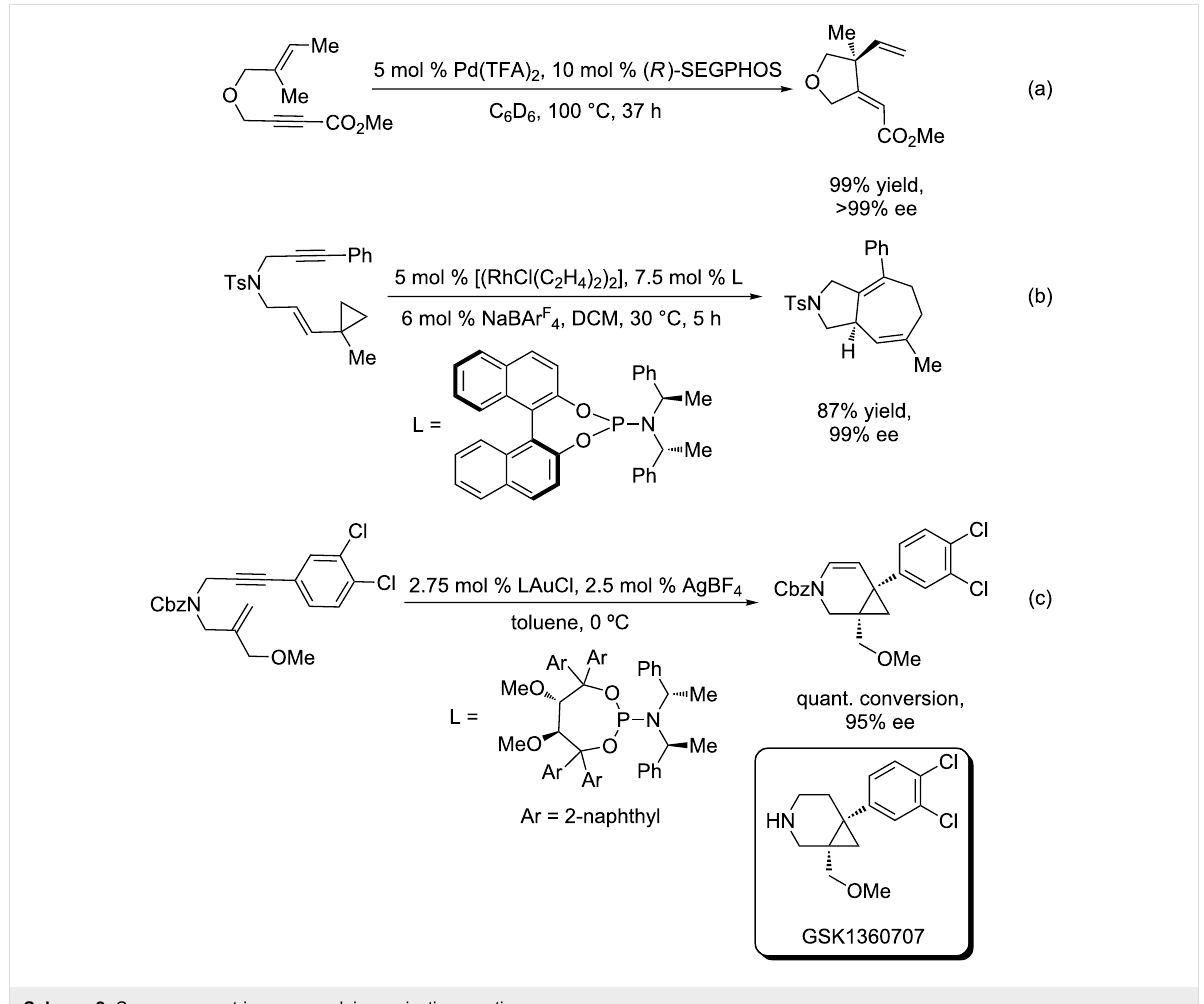
Scheme 2: Some asymmetric enyne cycloisomerization